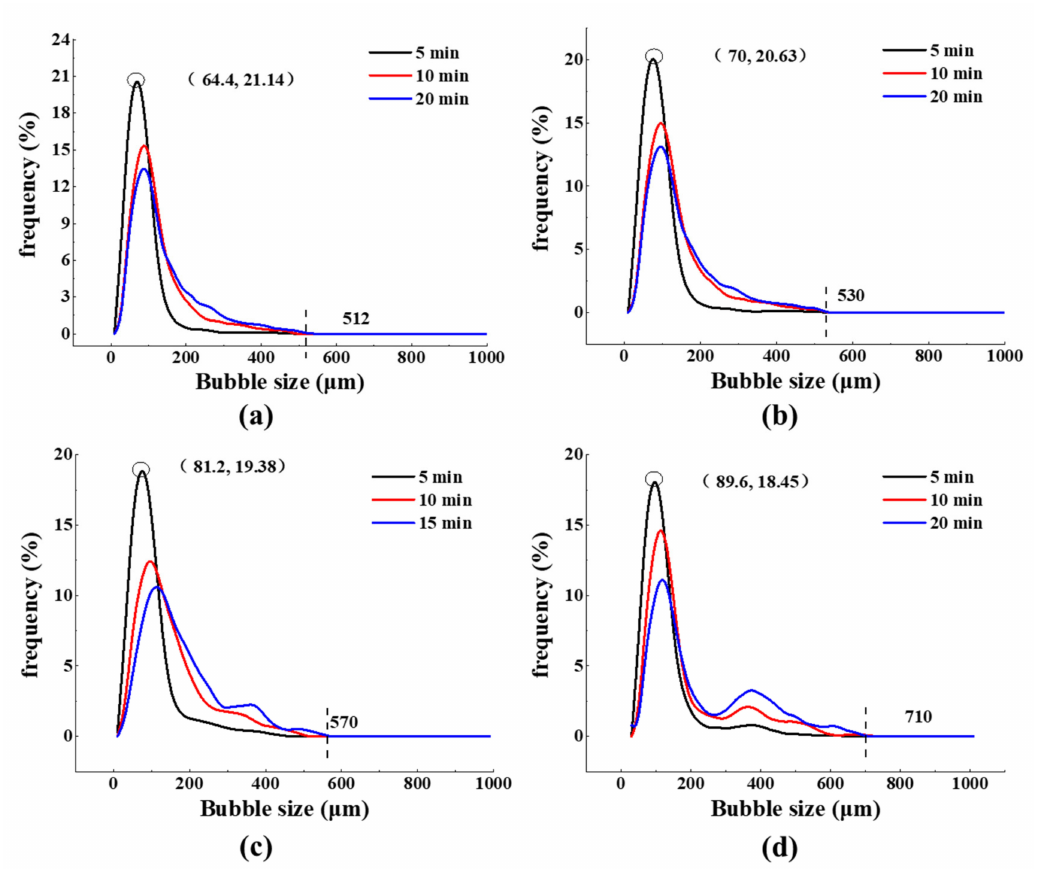
Figure 4. Particle size distribution during foam coarsening in different systems. ( a ) 50 g/L CaCl 2 , ( b ) 50 g/L MgCl 2 , ( c ) 50 g/L NaCl, and ( d )